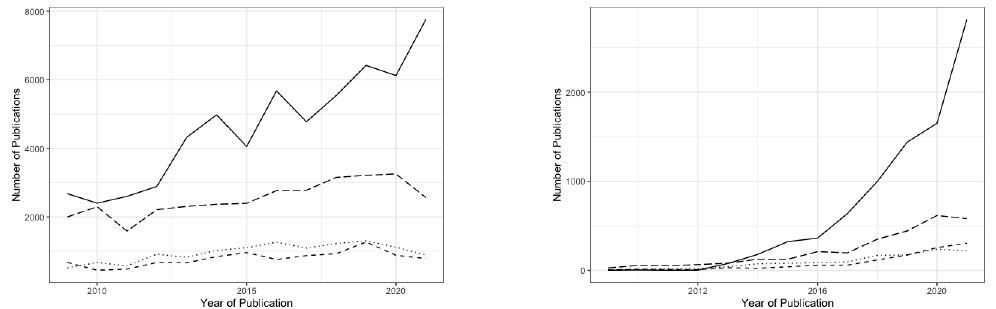
Figure 2. Articles published in the field of remote sensing ( left ) and in Remote Sensing from 2009 to 2021 by country (China = solid line; USA = long dashed line; Germany = dotted line; Italy = dashed